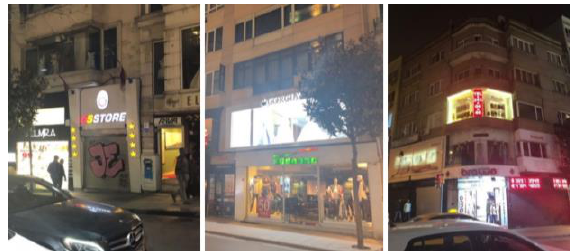
Figure 7 . Storefront Lighting (photo by